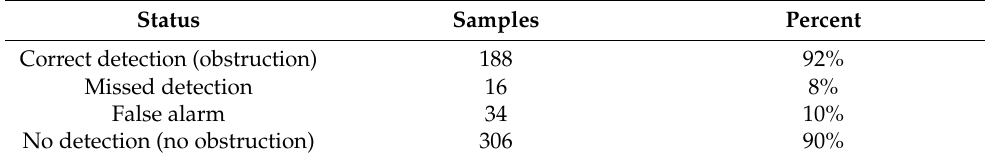
Table 3. Vision performance in terms of the correct detection, missed detection, and false alarm.